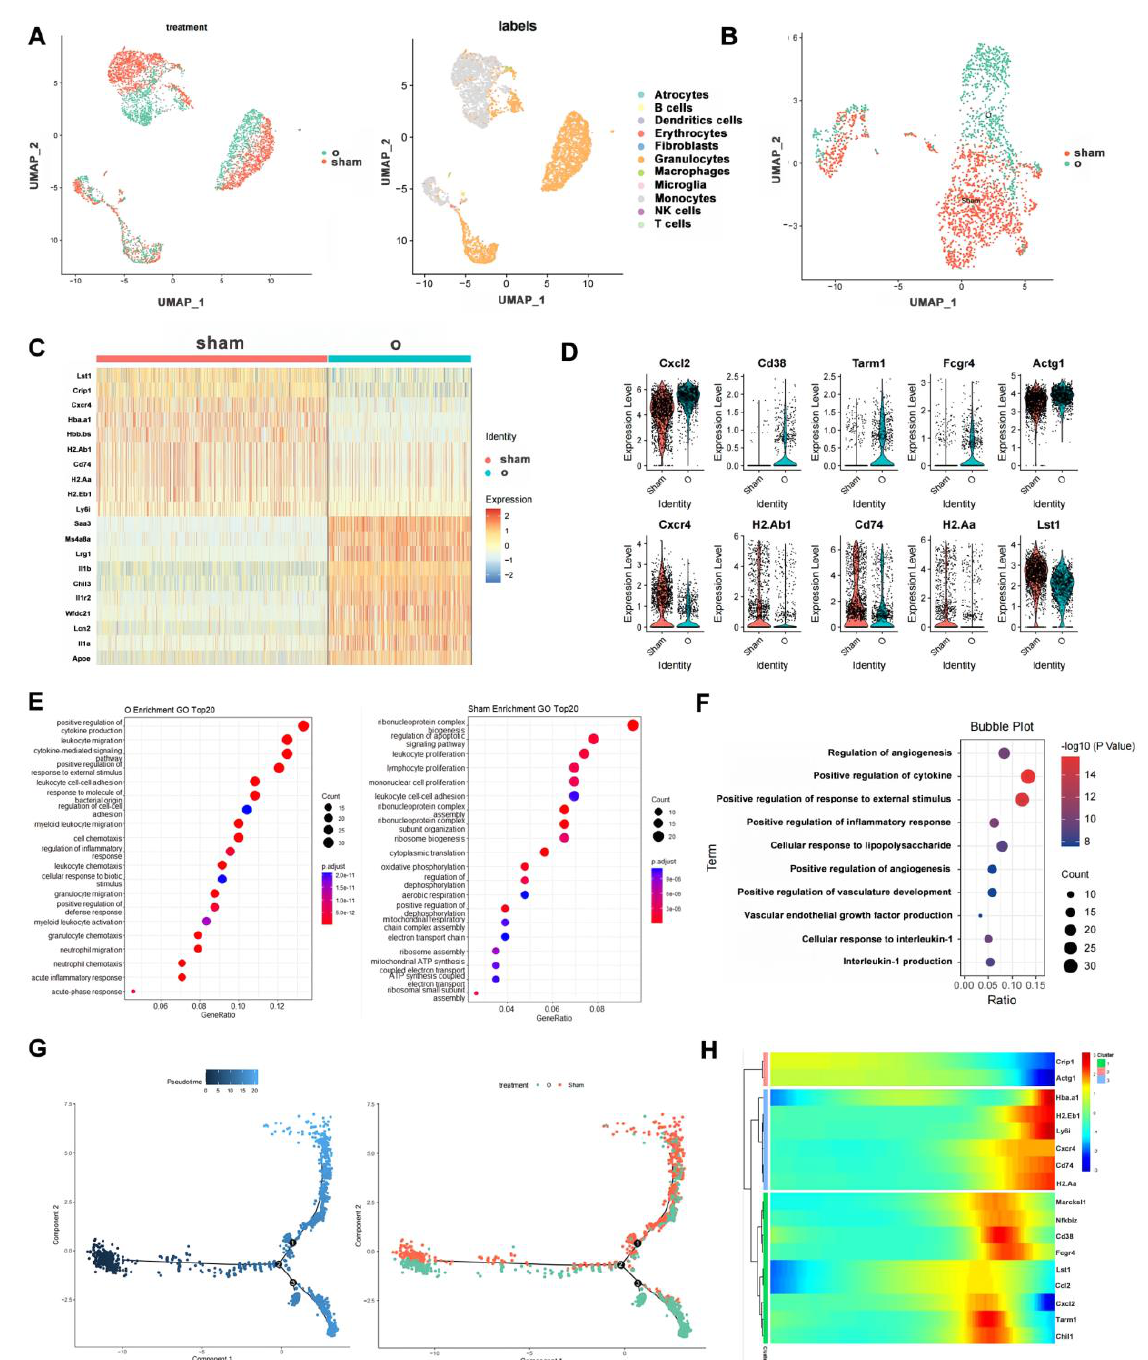
Figure 1. Single − cell sequencing data indicating that the macrophages in orthodontic alveolar bone have a positive effect on orthodontic tooth movement. Publicly available scRNAseq datasets were obtained from the Gene Expression Omnibus DataSets (GSM5640072 and GSM5640073): ( A ) uniform manifold approximation and projection (UMAP) plots of the total CD11b+ immune cell population isolated from the alveolar bone of normal and orthodontic mice; ( B ) UMAP plots of macrophages only; ( C ) Heat map of differentially expressed genes (DEGs) by two groups of macrophages, showing the top 10 DEGs; ( D ) Violin plot of DEGs for each group of macrophages; ( E ) Bubble plots showing the enrichment of GOBP terms in the two groups of macrophages; ( F ) Bubble plots of GOBP terms for DEGs in orthotopic groups; ( G ) Pseudotime and single − cell trajectory analyses using Monocle; ( H ) Heat map of representative pseudotime − dependent genes.